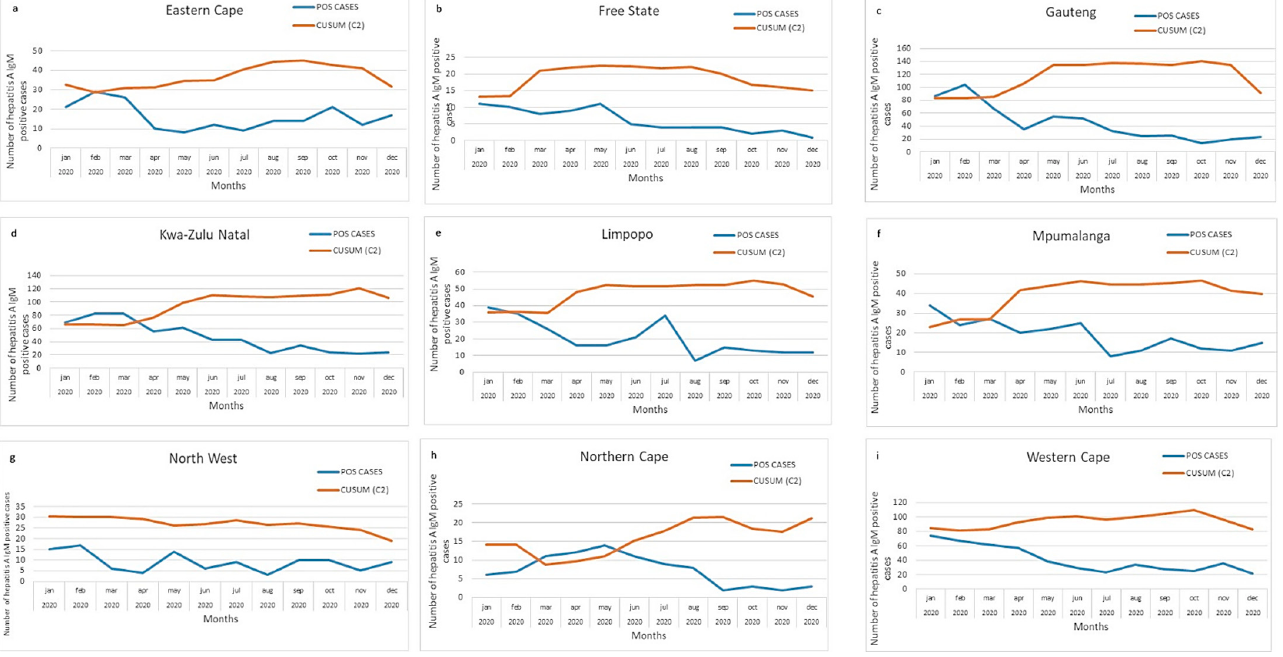
Figure 4. ( a – i ) Acute hepatitis A cases by province in South Africa, 2020. Number of hepatitis A cases (blue line) in comparison with threshold (orange line), calculated using CuSum2 method.